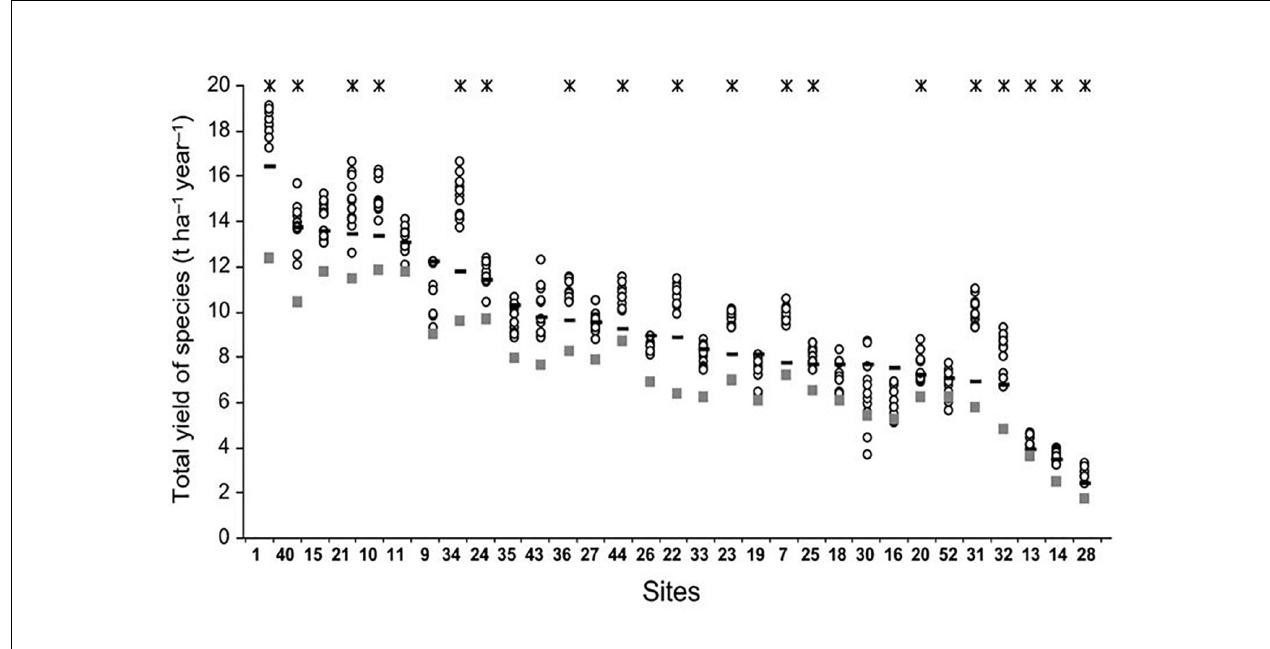
FIGURE 1 | Average annual total yield at each of 31 sites of a 3-years pan–European experiment in 17 countries testing whether higher yields, compared with monocultures, can be achieved with grass–legume mixtures containing four species [adapted from Finn et al. (2013)]. At each site open circles represent mixture yields, horizontal bar the yield of the best performing monoculture, gray square mean monoculture performance, and asterisk sites where mixture yields exceeded those of the best